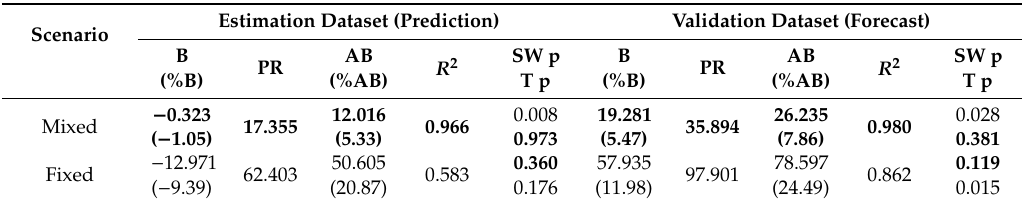
Figure 8. Evolution of stand volume per hectare over age. ( M1 ) mixed effects scenario for the first stand; ( M2 ) mixed effects scenario for the second stand; ( M3 ) mixed effects scenario for the third stand; ( F ) fixed effects scenario for all stands; black solid line–stand volume prediction curve; black dot line–stand volume forecast curve; black circles–estimation dataset, red circles–validation (forecast) dataset. Table 5. Statistical indexes and p -values of the Shapiro-Wilk (SW p ) and Student (T p ) tests for the stand volume (m 3 ha − 1 ) model (Equation (25))